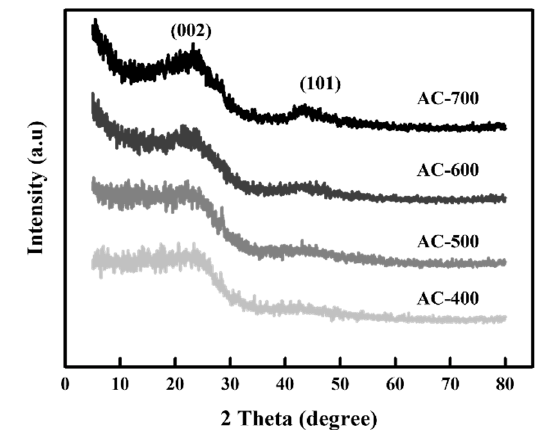
Figure 1. XRD patterns obtained for AC-400, AC-500, AC-600, and AC-700, as indicated.